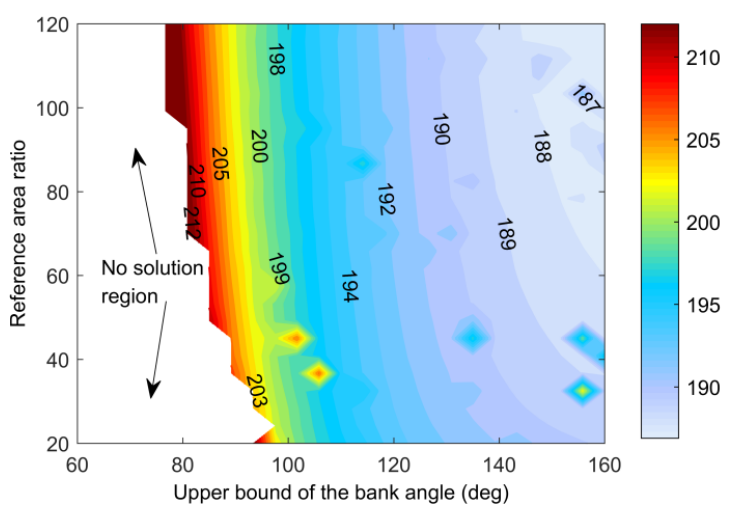
Figure 12. Minimum insertion impulse (unit: m/s) with different upper bounds in terms of the bank angle and reference area ratios.